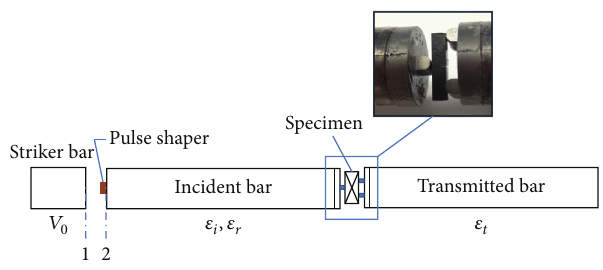
Figure 5: Schematic of the modified SHPB setup for fracture